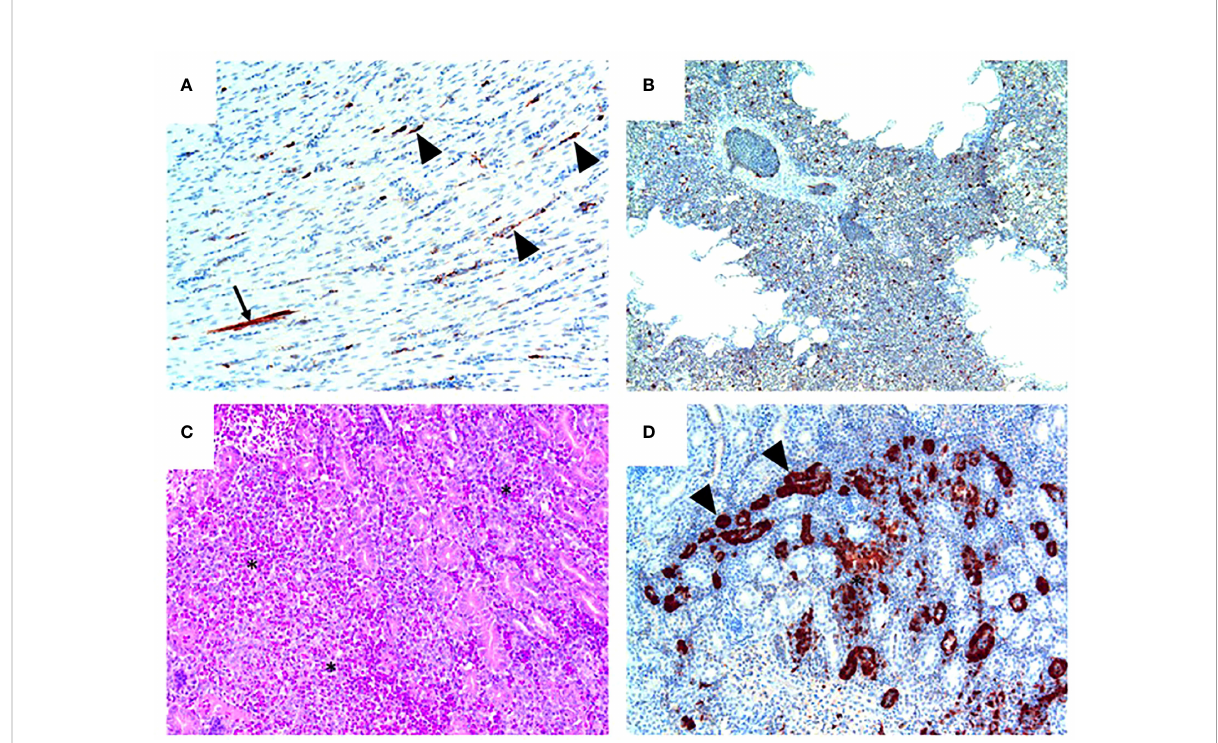
FIGURE 5 Pathology and H7N9 antigen tropism in chickens inoculated with the NP 373T bearing variant of A/Anhui/1/13 (H7N9) by the intravenous route. (A) Heart (chicken 5) showing viral antigen capillary endothelium (arrowheads) and in a single myocardial fi bre (arrow); tissue morphology is normal in this heart. (B) Lung (Chicken 8) showing viral antigen within single cells; tissue morphology is normal in this tissue. (C) Kidney (Chicken 4) showing acute interstitial and tubular necrosis, haemorrhage and histiocytic in fi ltration (*). (D) Kidney (Chicken 4; consecutive section to that shown in (C) showing viral antigen in tubular epithelium (arrowheads) and localised necrosis (*). Immunohistochemistry for in fl uenza nucleoprotein (red-brown pigment), counterstained with haematoxylin (A, B, D) ; haematoxylin and eosin stain (C)